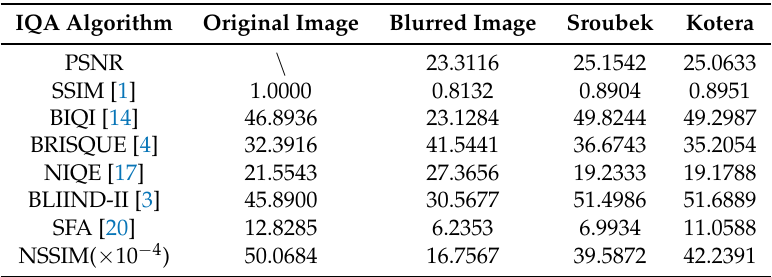
Table 12. IQA algorithms performance on Group 2 restorations. Original image is the reference (sharp) image given by IVC [27] dataset. NSSIM represents the quality score given by the proposed